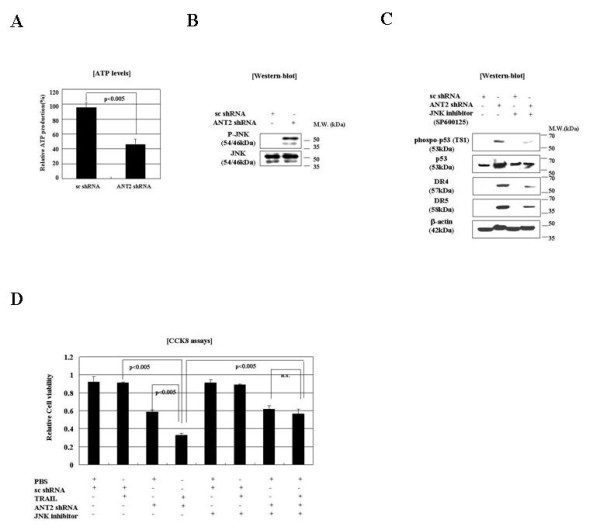
Transfection of ANT2 shRNA leads to JNK activation and subsequent up-regulation and activation of p53 in MCF7 cells. (A) Analysis of ATP levels in lysates of MCF7 cells pre-treated with the JNK inhibitor SP600125 for 2 h and then transfected with scrambled or ANT2 shRNA for 24 h. The data are shown in relative luminescence units (RLU) calculated by normalizing total intracellular ATP to total protein. (B) MCF7 cells treated as in (A) were analyzed for JNK phosphorylation by immunoblotting using anti-phospho JNK and anti-JNK antibodies. (C) Effect of JNK inhibition on ANT2 shRNA-mediated upregulation of DR4 and DR5. MCF7 cells were treated with SP600125 and scrambled or ANT2 shRNA as in (A). Cell extracts were subjected to SDS-PAGE and immunoblotted with antibodies against phospho-p53, p53, DR4, DR5, and β-actin (control).